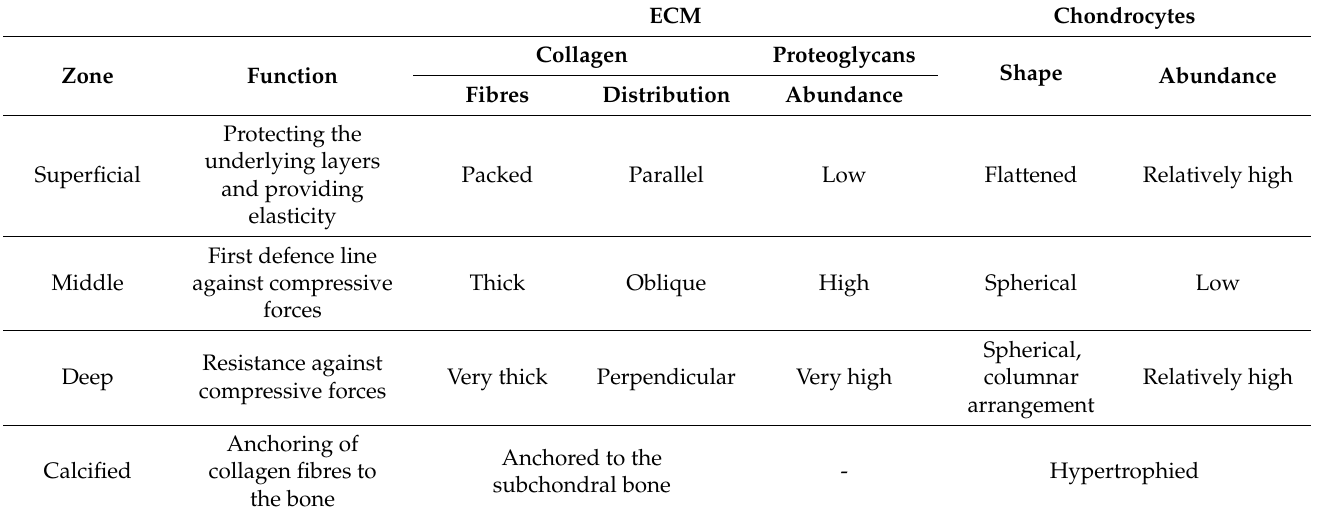
Table 1. Structural characteristics of normal osteochondral